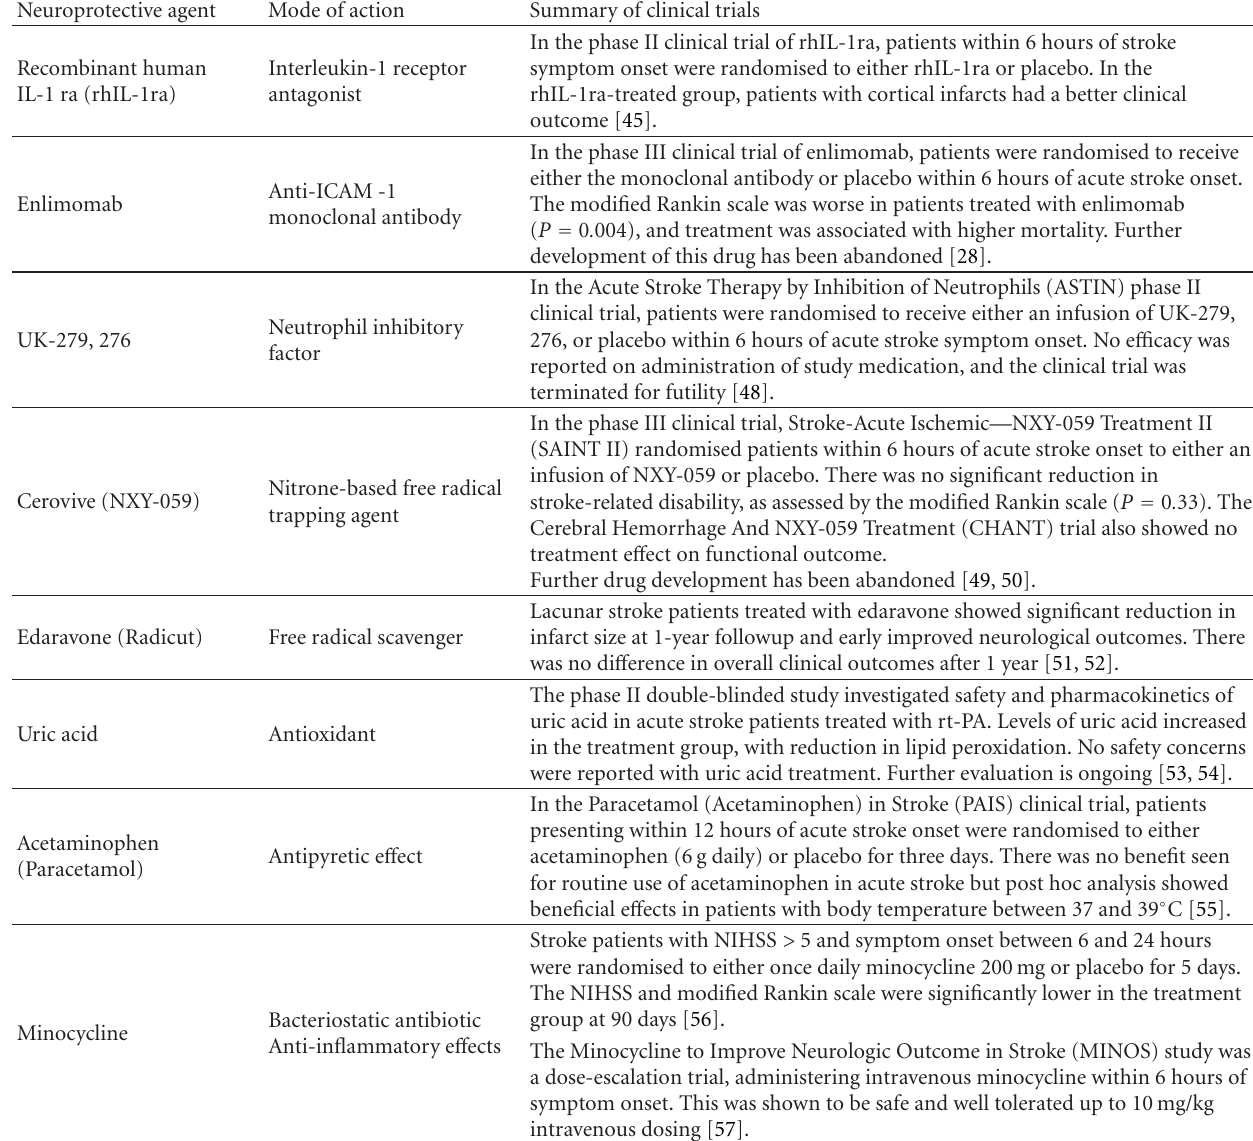
Table 1: Neuroprotective agents targeting neuroinflammation in acute